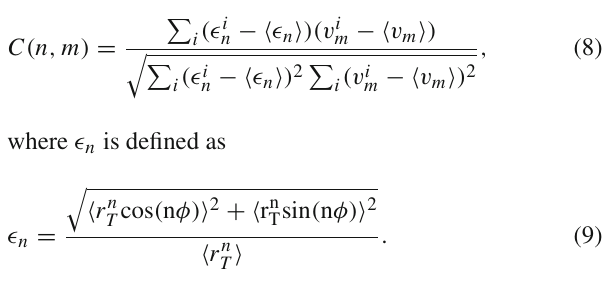
of minijets decreases v 2 and v 3 at p T (cid:4) 2.5 GeV / c ,